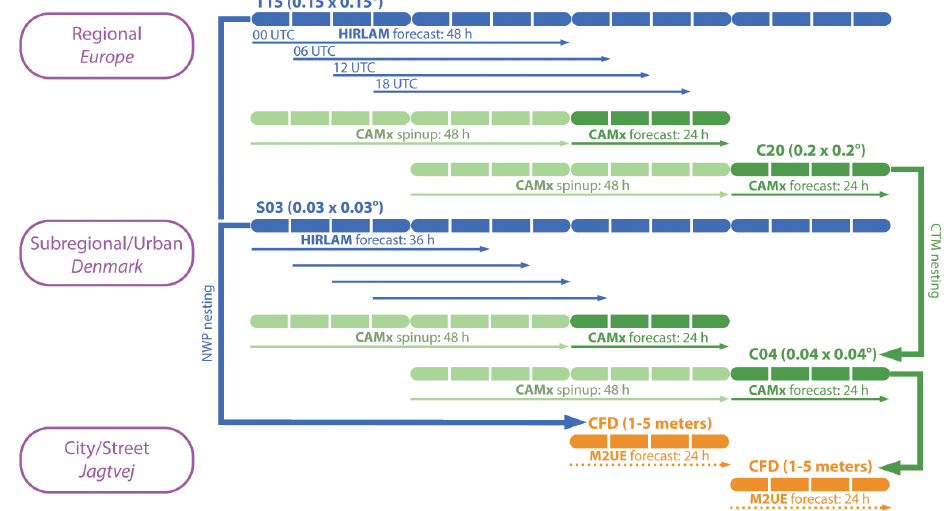
Figure 2. Downscaling modeling system: from the European regional-scale forecast (HIRLAM-T15 + CAMx-C20) to the subregional-urban Denmark (HIRLAM-T03 + CAMx-C04) and city-street scale for Copenhagen (CFD M2UE); the blue, green, and orange horizontal bars indicate NWP HIRLAM, CTM CAMx, and CFD M2UE forecasts, respectively; horizontal and vertical arrows indicate the forecasts’ cycles and downscaling (data flow),